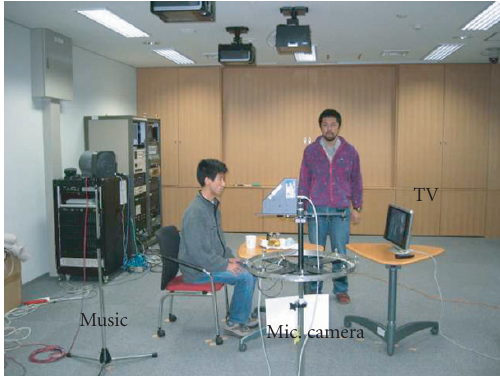
Figure 9: Setting of